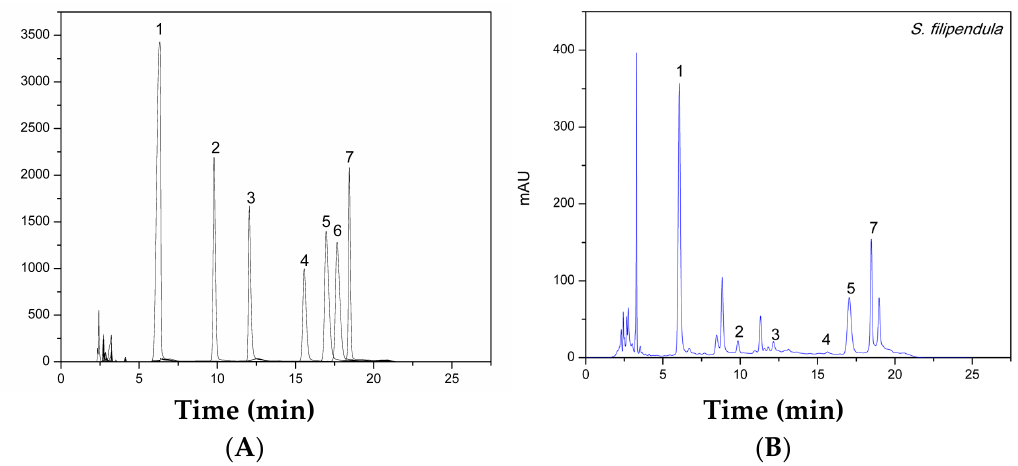
Figure 3. HPLC profile of monosaccharide standards ( A ) and hydrolyzed polysaccharide crude extract from S. filipendula ( B ). 1: PMP. 2: Mannose. 3: Glucuronic acid. 4: Glucose. 5: Galactose. 6: Arabinose. 7: Fucose. Table 3. Phlorotannins in polyphenol crude extract from S. filipendula . Suggested Retention Molecular Compound Florotannin Time (min) Formula